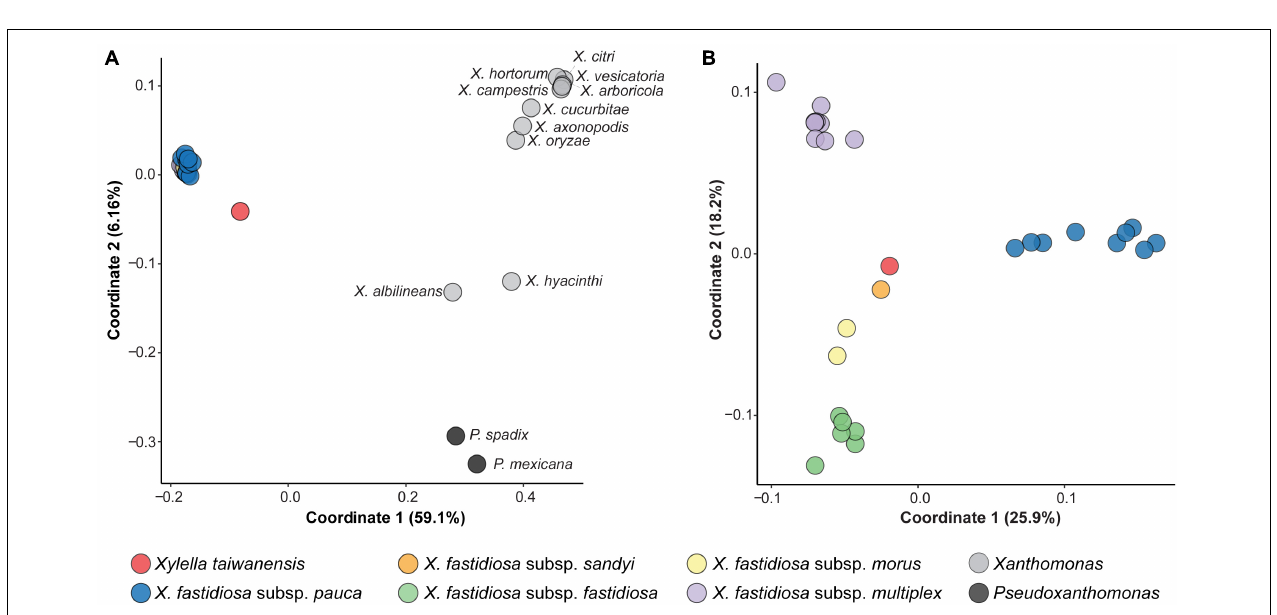
FIGURE 2 | Genome similarity among the representative Xylella strains. The pairwise comparisons were classified into three categories: (1) within the same X. fastidiosa subspecies, (2) between different X. fastidiosa subspecies, and (3) between X. fastidiosa and X. taiwanensis .